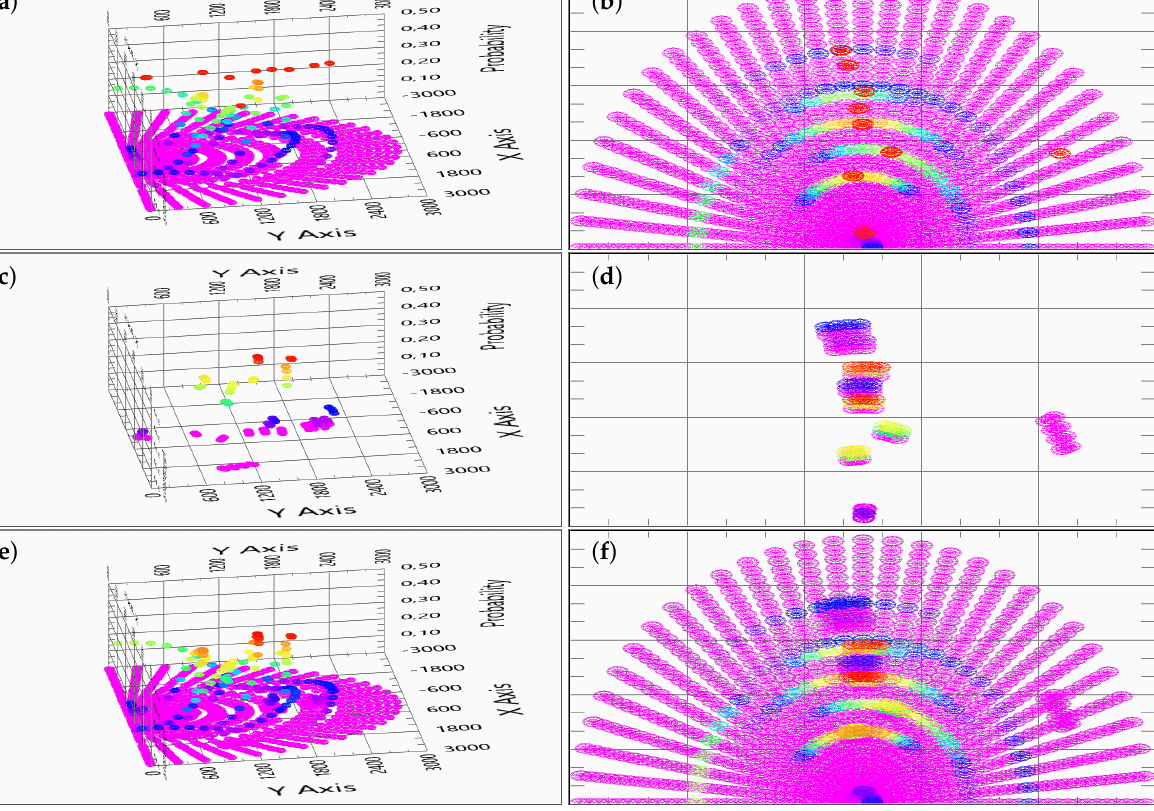
Figure 16. Redefinition of the raster by wavelet-based local refinement steps. First row (subplot ( a , b )) shows the low- resolution result with the peak points indicated in red; second row (Subplot ( c , d )) gives the refinement points; and the last row (Subplot ( e , f )) sums up the two previous results. On the left hand side are the 3D plots and on the right hand side, the top views are